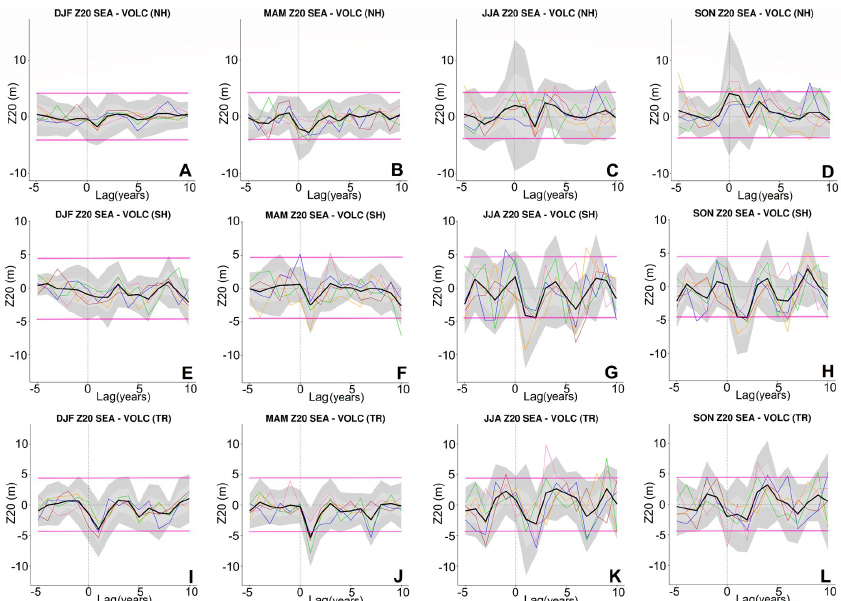
Vertical: seasonal SEA (December to February – DJF; March to May – MAM; June to August – JJA; and September to November – SON). Dark red line corresponds to the CTRL run, and light shaded red corresponds to one standard deviation of the CTRL run.